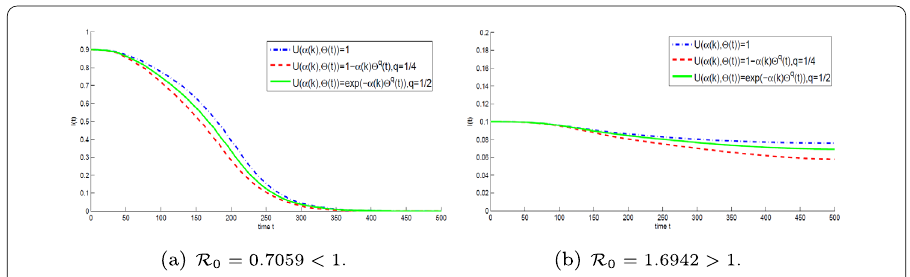
Figure 1 The time series of I ( t ) with different forms of feedback mechanism